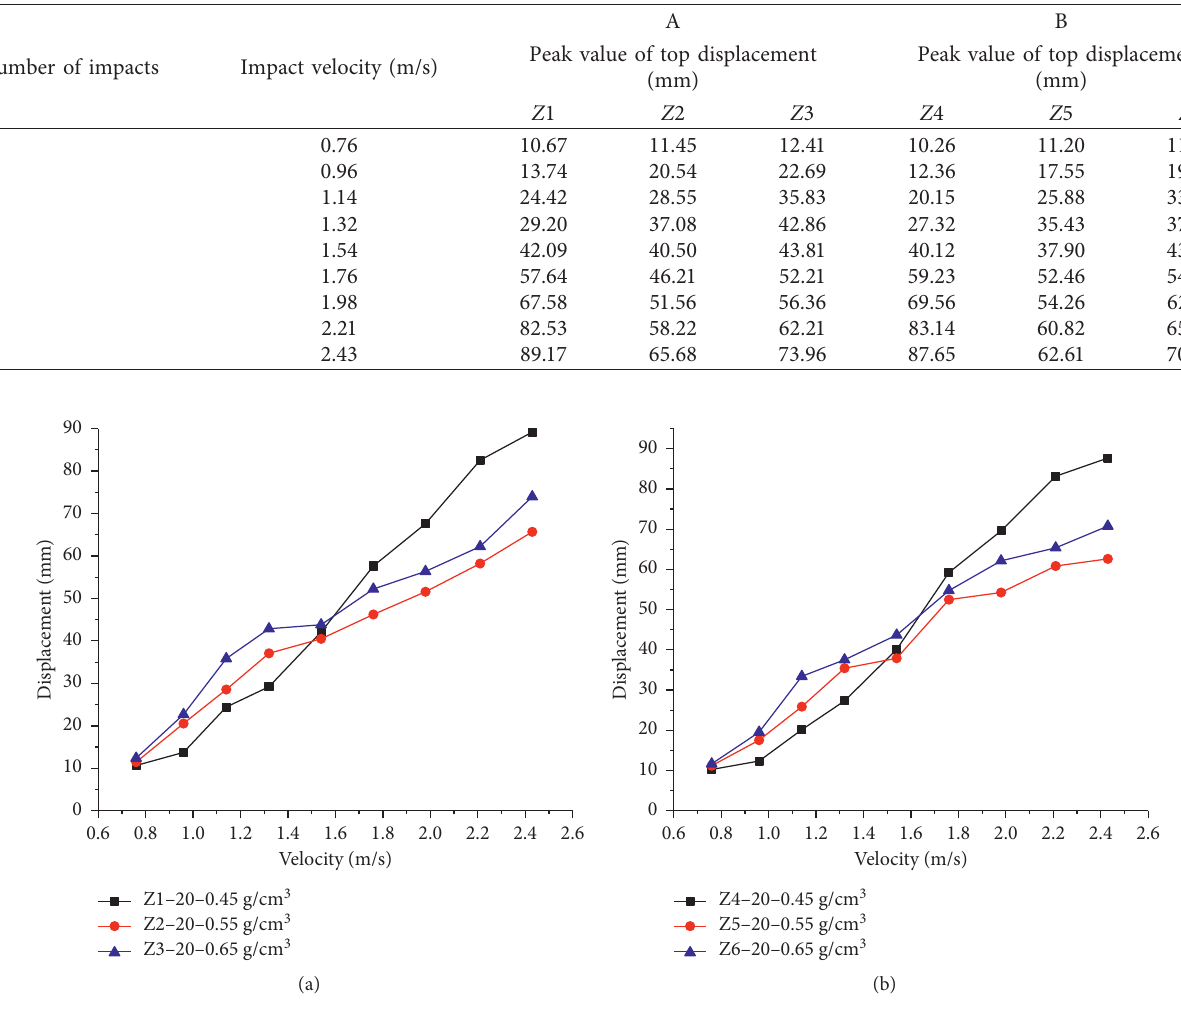
Figure 12: Top displacement peak